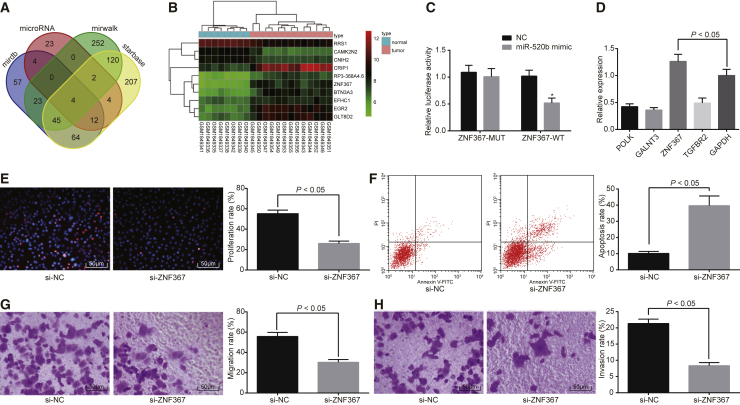
ZNF367 Is Targeted by miR-520b, and the Silencing of ZNF367 Inhibited PC Cell Proliferation, Migration, and Invasion(A) miRDB, microRNA.org, miRWalk, and starBase v2.0 databases were applied to predict the target genes of miR-520b. (B) The heatmap of differentially expressed genes in GEO: GSE71989 (the x axis represented sample number; the y axis represented the names of differential expressed genes). The histogram in the upper right represented color gradation with the change of color from top to bottom, which illustrated that the expression in the profiling data was in descending order. Each of the rectangles corresponded to the expression of each sample, and each column represented the expression of all genes. The dendrogram in the left was the cluster analysis results of different genes from different samples. The upper band represented the sample type. In the upper-right color gradation, blue represented the normal control sample, and red represented PC tumor sample. (C) Verification of the binding relationship between miR-520b and ZNF367 by the dual-luciferase reporter gene assay. (D) mRNA expression of differentially expressed genes in the PC cells determined by qRT-PCR. (E) Silencing of ZNF367 suppressed the proliferation of PC cells detected by the EdU assay (×200). (F) Silencing of ZNF367 enhanced the apoptosis of the PC cell detected by flow cytometry. (G) Silencing of ZNF367 suppressed the migration of PC cells detected by the Transwell assay (×200). (H) Silencing of ZNF367 decreased the invasion of PC cells detected by the Transwell assay (×200). *p < 0.05 versus the ZNF-367-Mut group. Data in the figure were measurement data, which were expressed as mean ± standard deviation and compared by independent-sample t test. The data of expression detected by qRT-PCR were compared by one-way ANOVA. The experiment was repeated 3 times independently.